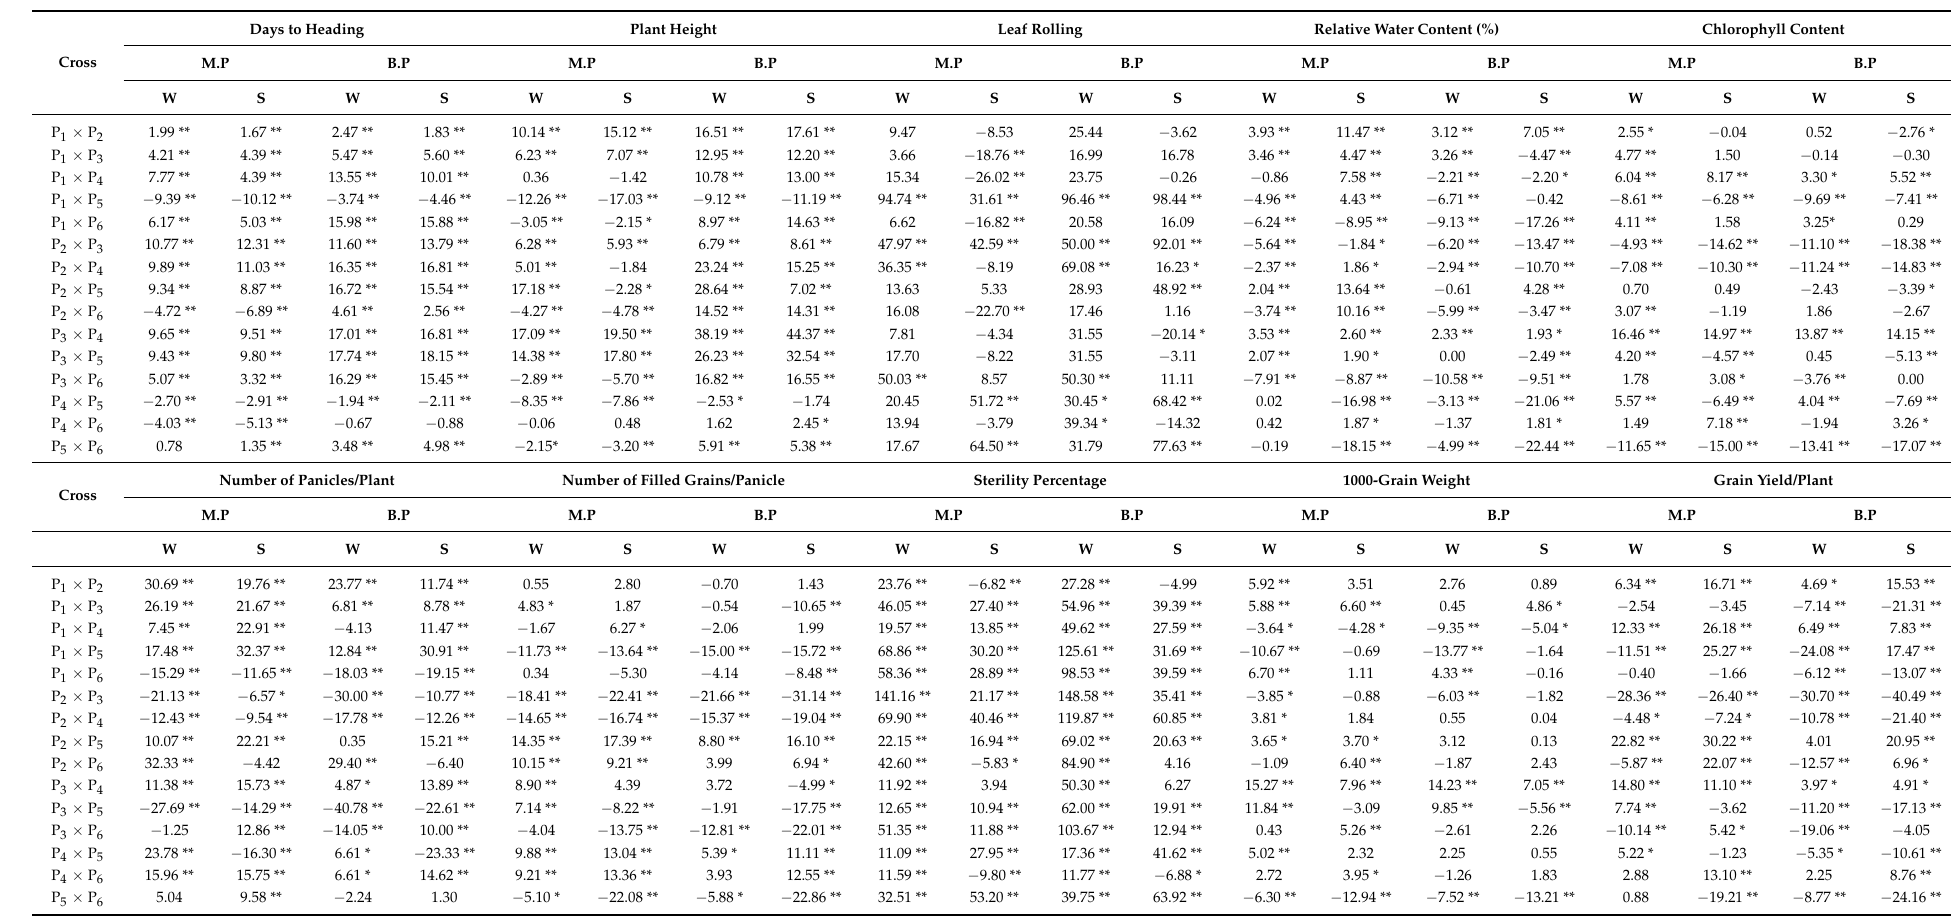
Table 5. Heterosis relative to Mid-Parent (MP) and Better-Parent (BP) of the 15 F 1 hybrids for all evaluated traits under well-watered (W) and water-deficit (S)